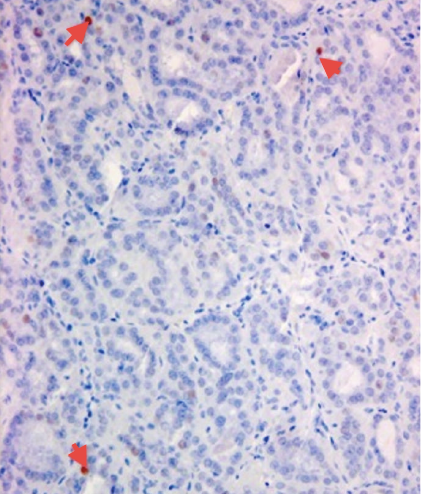
Figure 4: Immunohistochemical features. It should be noted that also Hashimoto thyroiditis may show reactivity for Galectin-3, but it is typical focal and restricted to epithelial cells in the areas of lymphocytic infiltrations. OA: only few cells show a weak positivity for cyclin D3